Question: What caption would you write for this figure?
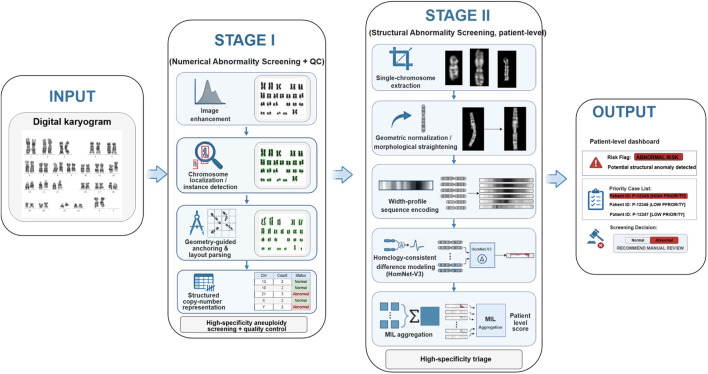
Answer: Distribution of numerical chromosomal abnormalities in the Stage I abnormal dataset.